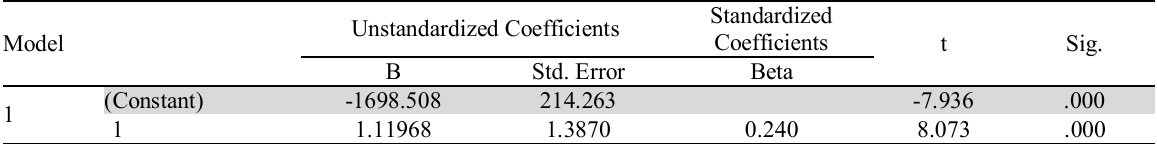
The results of regression analysis (Dependent Variable: GPR)